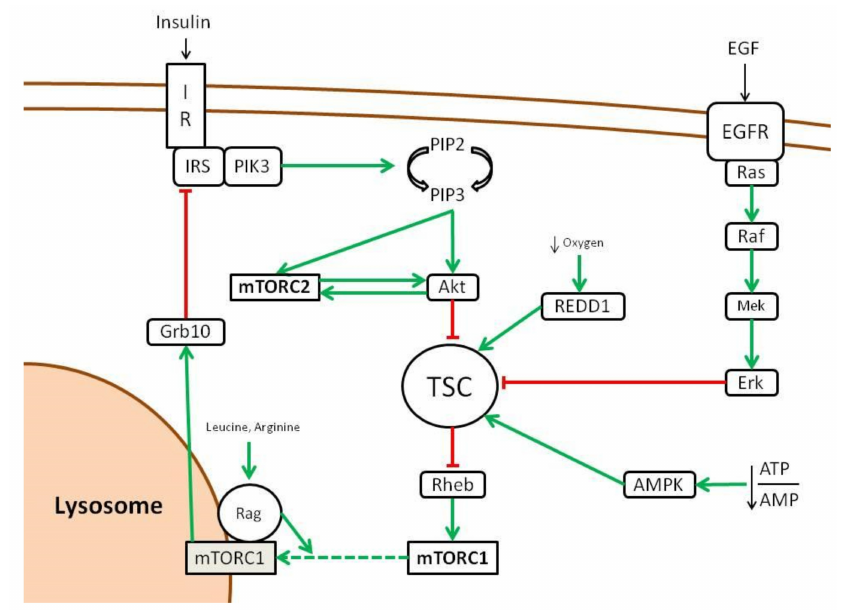
Figure 2. Upstream regulation of mTOR pathway (adapted from [16]). Green lines show activating signals, red lines show inhibitory signals, dashed lines indicate that the exact mechanism is